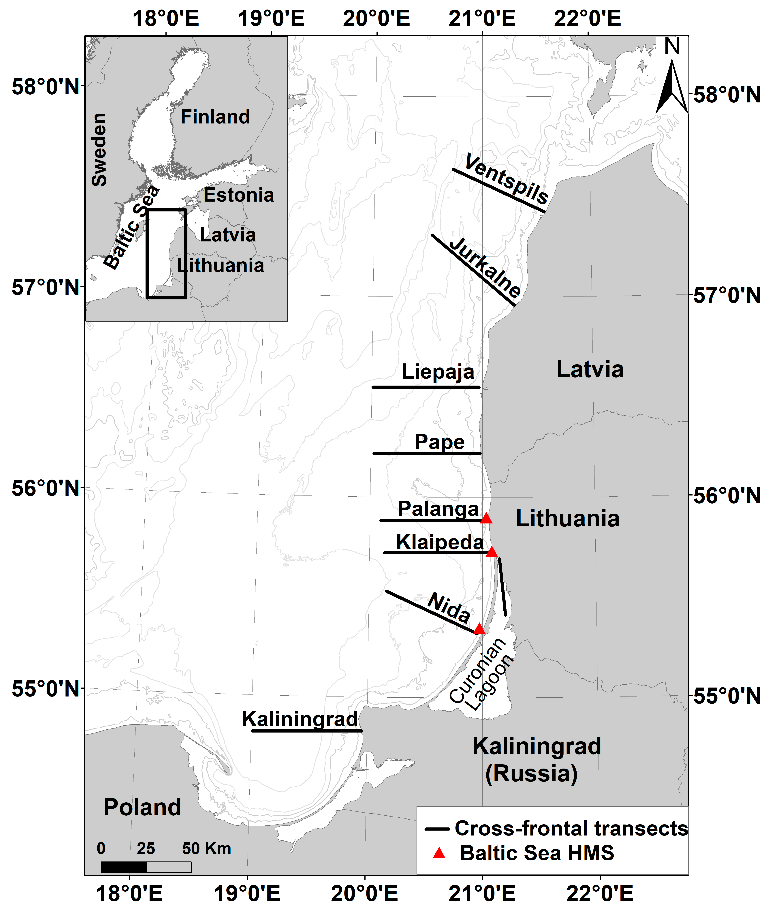
Figure 1. Map of the study site in the south-eastern (SE) Baltic Sea showing the locations of the cross-frontal transects and hydrometeorological stations (HMS).